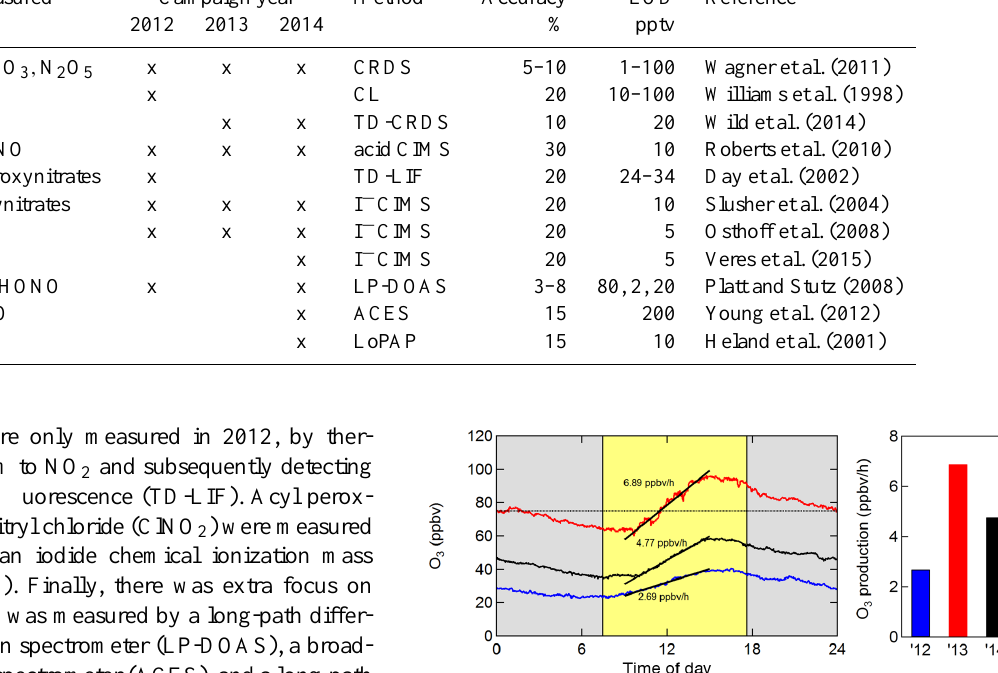
Table 1. Measurements of ambient gas-phase reactive nitrogen during UBWOS 2012–2014. The method abbreviations are described in Sect. 2, and LOD refers to the limit of detection. Not all measurements were used in this analysis. Species measured